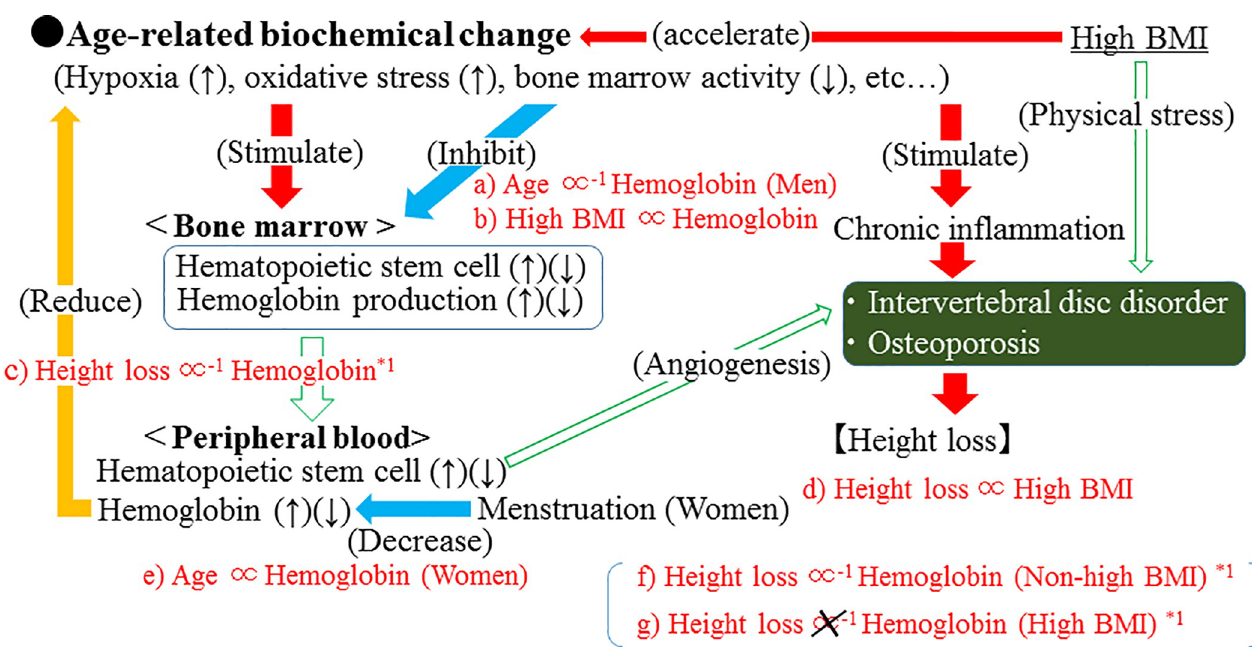
Fig 2. Potential mechanism underlying the association between hemoglobin and height loss. Associations shown in red (a–g) were observed in the present study. High BMI was defined as � 25kg/m 2 . � 1: Observed only among men.